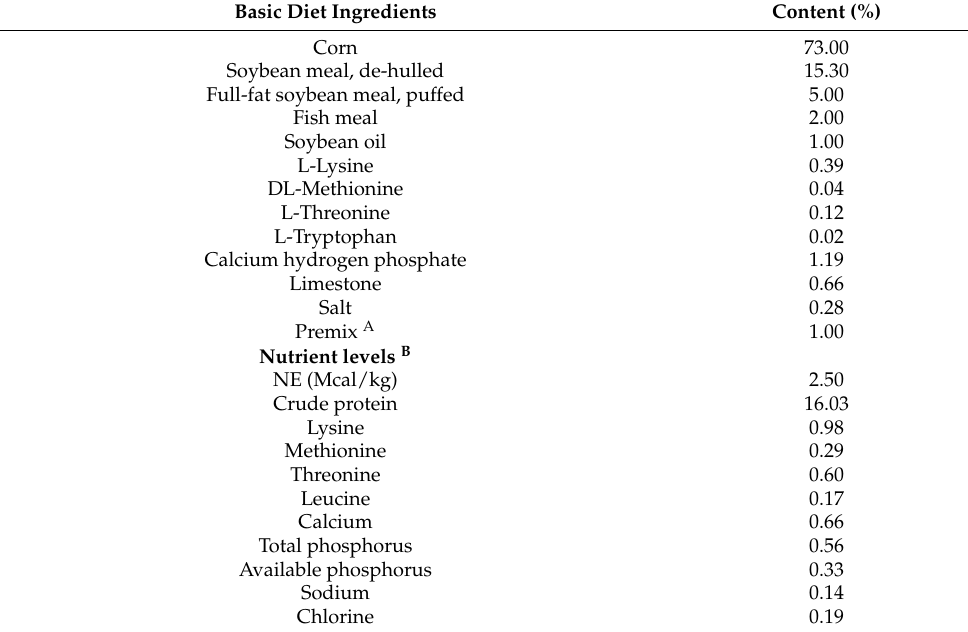
Table 1. Composition of experimental